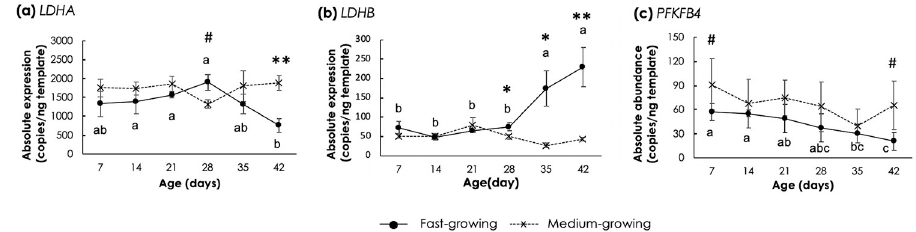
Fig 3. Absolute transcript abundance of genes involved in carbohydrate metabolism in Pectoralis major muscle of fast- and medium-growing chickens at different ages. The genes include (a) lactate dehydrogenase isoform A ( LDHA ), (b) lactate dehydrogenase isoform B ( LDHB ), and (c) 6-phosphofructo-2-kinase/fructose2,6-biphosphatase 4 ( PFKFB4 ). Markers and error bars depict mean and standard deviation (n = 5). Lower case letters indicate significant differences among fast-growing chickens. Asterisks and sharp signs indicate significant differences between the two strains at the same age. # p < 0.1, � p < 0.05, �� p < 0.01.